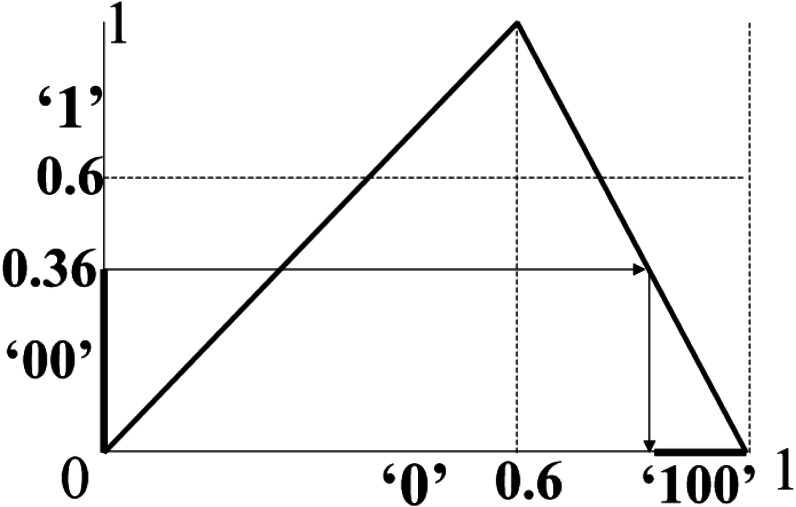
GLS-coding: an example.For the message M = 0010110100 (L = 10, p=0 .6), the above figure shows the backward-iteration from 00 to 100 on the GLS T0.6. With [START0, END0) = [0.0, 1.0) and iterating backwards, we obtain [START1, END1) = [0.0, 0.6), [START2, END2) = [0.0, 0.36), [START3, END3) = [0.8560, 1.0) and so on. In this figure, when we go from the symbols 00 to 100, we go from [START2, END2) = [0.0, 0.36) to [START3, END3) = [0.8560, 1.0) since the symbolic sequence at this iteration is 1. This process is repeated until we have a final interval [STARTL−1, ENDL−1) for the entire M.